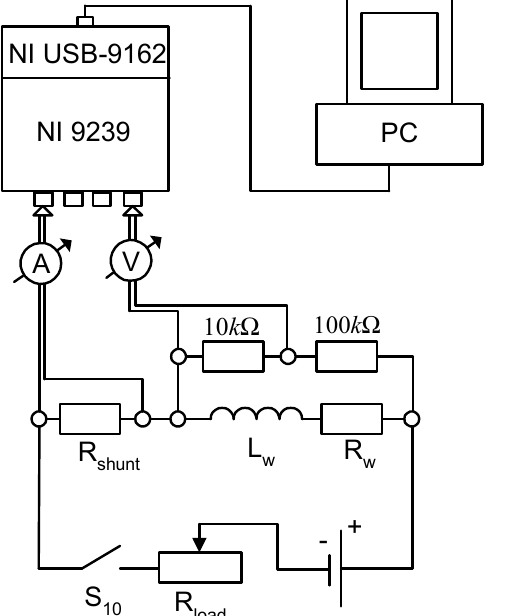
Figure 16. Experimental setup for measuring the electrical resistance of motor windings.